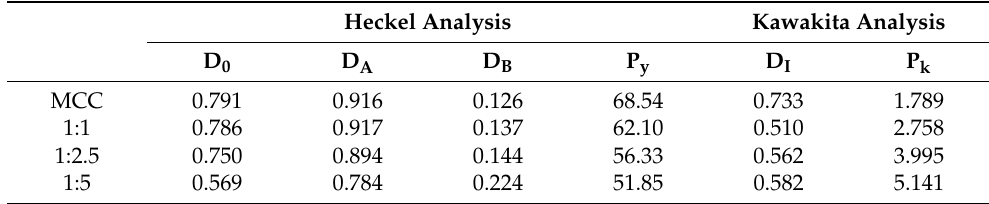
Table 4. Parameters involved in Heckel and Kawakita analysis for tablet constituting MCC-SiO 2 conjugates in the ratios 1:1, 1:2.5 and 1:5.